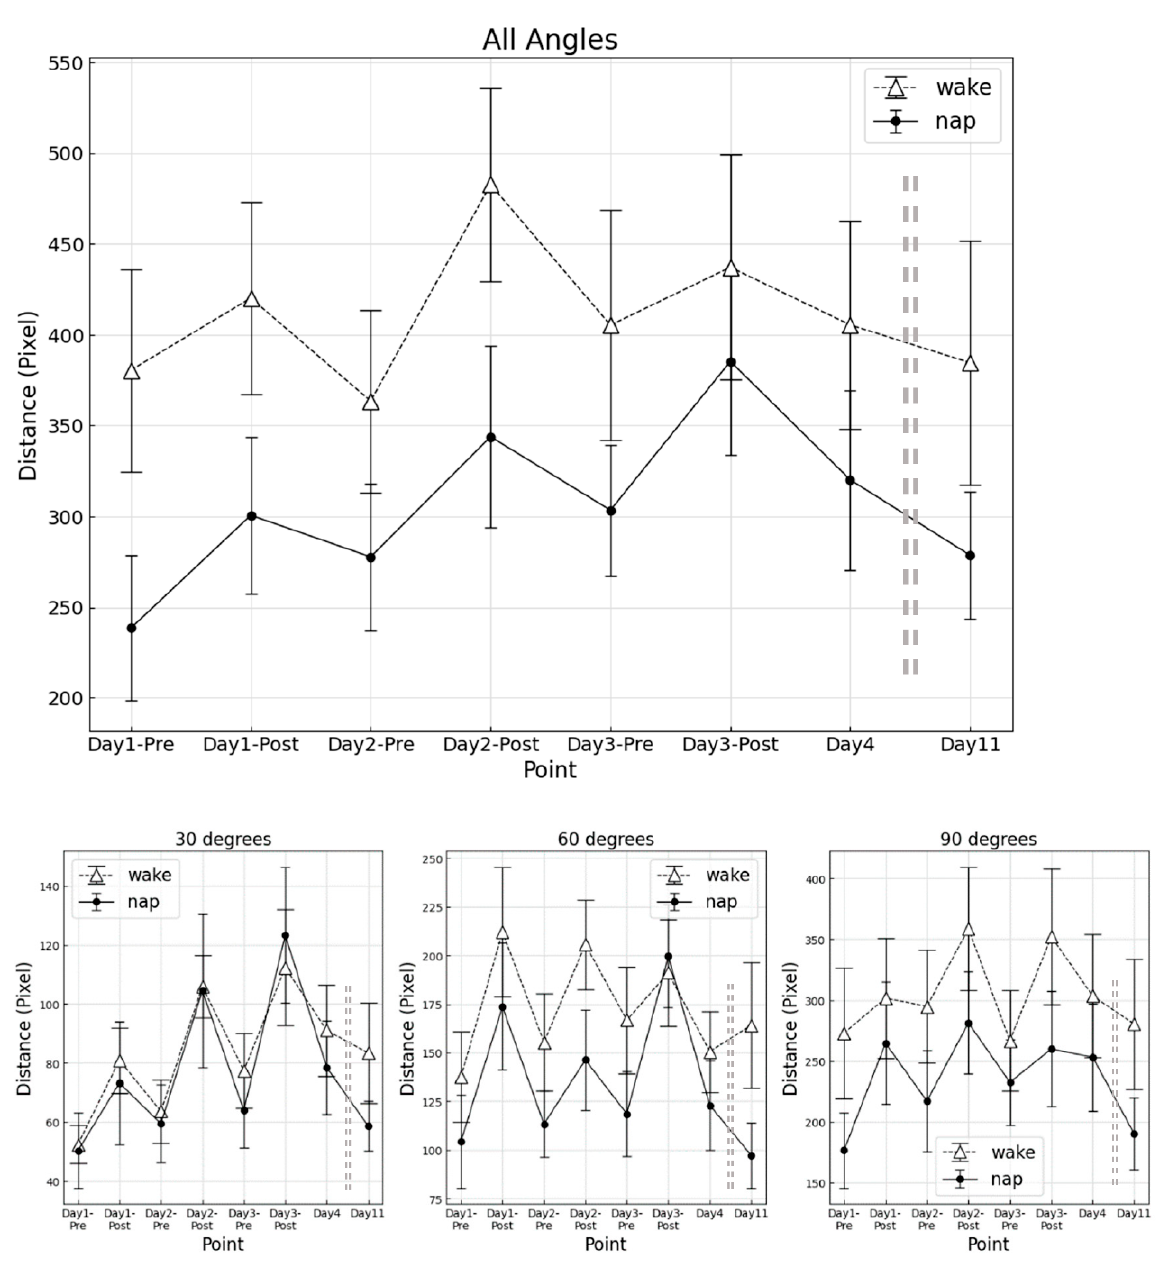
Figure 2. Trajectory length at each measurement point. Upper, averaged angle; Lower left, 30°; middle, 60°; right, 90°. Error bars mean standard error.